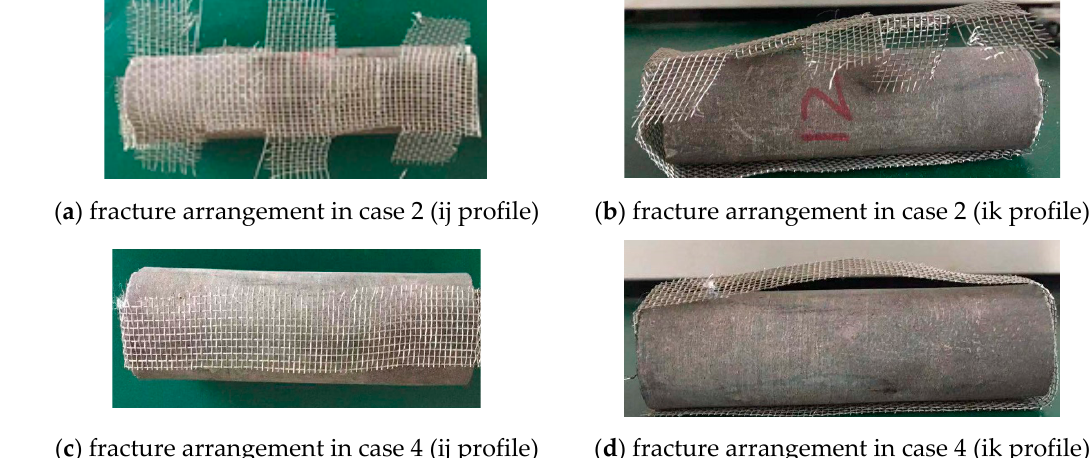
Energies 2019 , 12 , 823